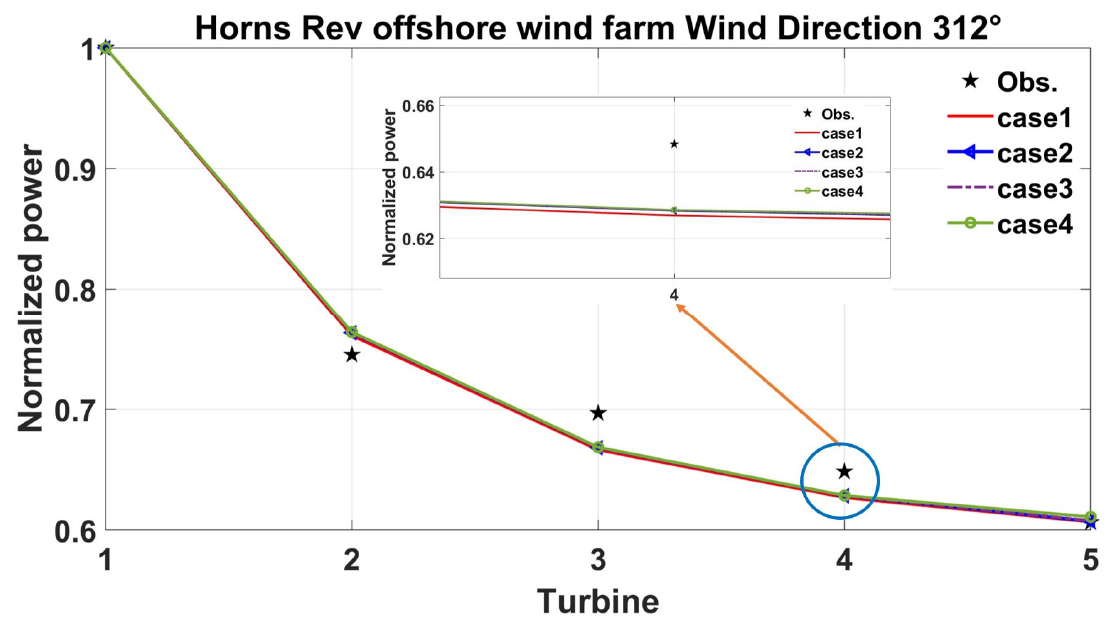
Figure 3. Grid refinement study of simulated power results with a wind direction of 312°.